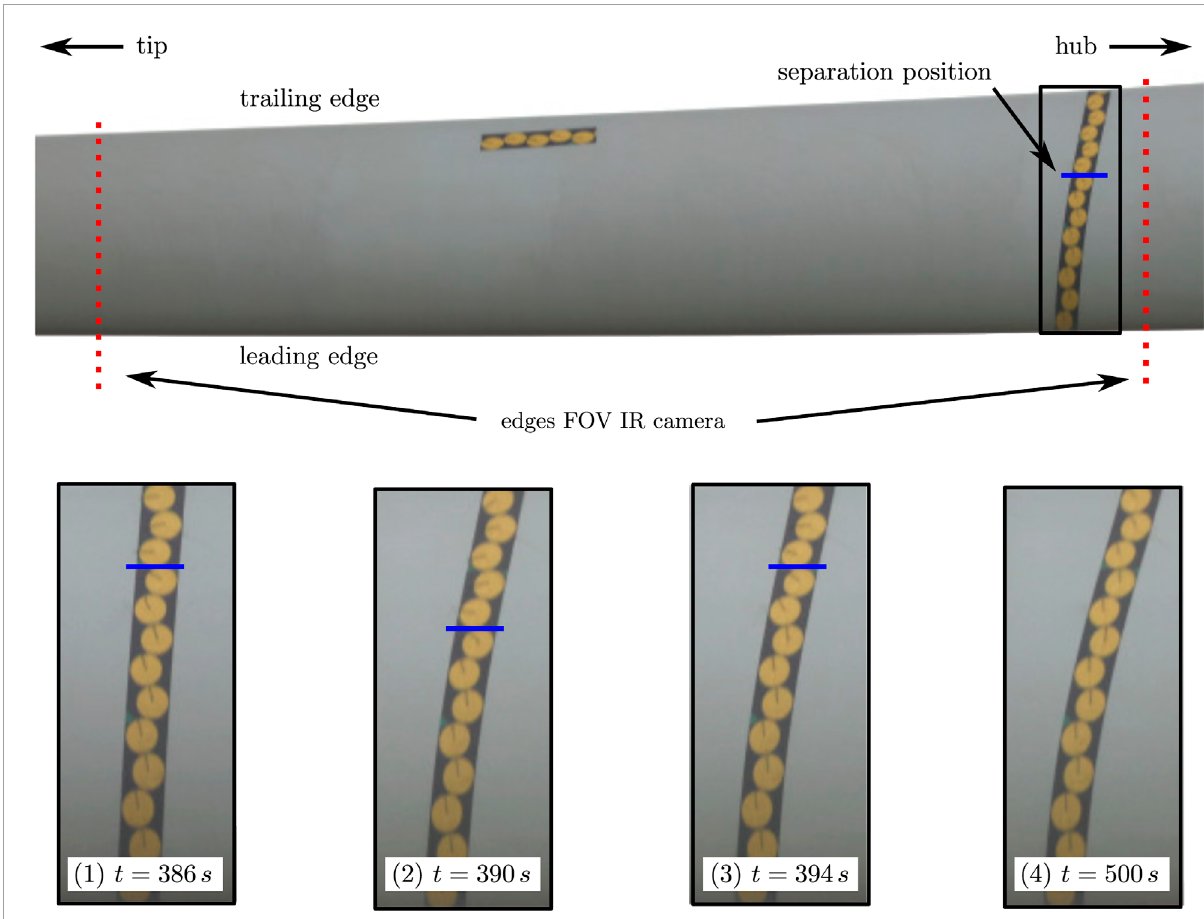
FIGURE 6 Verification of the occurrence and position of unsteady flow separation for the IR camera’s field of view using tufts flow visualisation. The blue solid lines across the tuft tapes reveal the occurrence and position of unsteady flow separation at different times. The location of the separation point is identified by a zero chord-wise alignment component of the